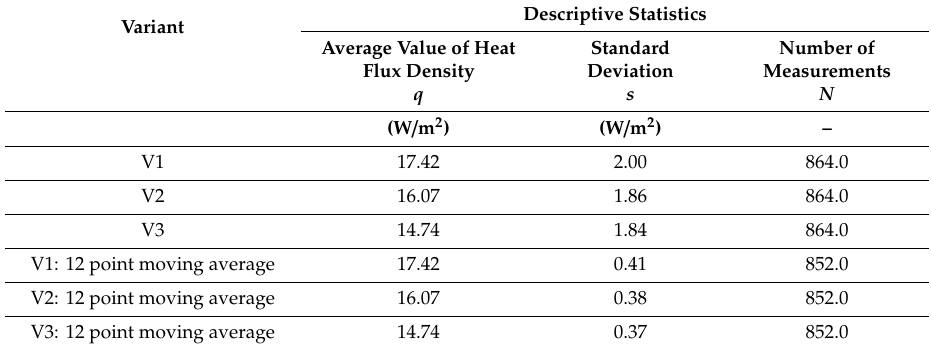
Table 2. Descriptive statistics for three partition variants before and after transformation of the series.